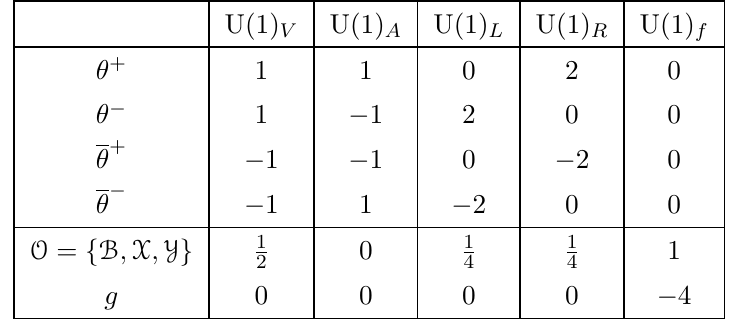
Table 2 . Charge assignments under the R -symmetries and global symmetries relevant for the non-renormalization